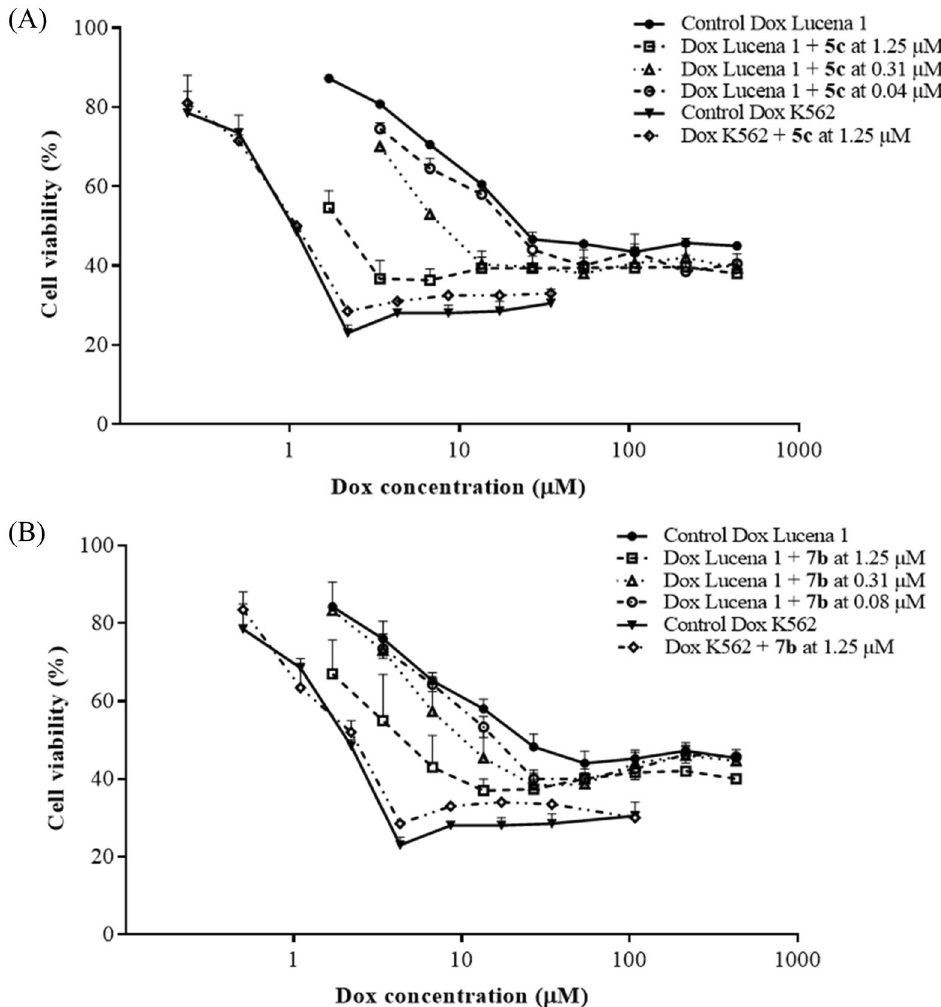
Figure 4. Dose–response curves for restoring sensitivity in Lucena 1 treated with doxorubicin (Dox) as an antineoplastic drug in the absence or presence of ( A ) compound 5c and ( B ) compound 7b . In Lucena 1 cells, doxorubicin toxicity was significantly increased when compounds 5c and 7b were co-administered from 0.04 and 0.08 µM, respectively ( p < 0.05). The same assay was performed in K562 to discard additional effects other than P-gp. Values are expressed as means ± SE of at least three independent